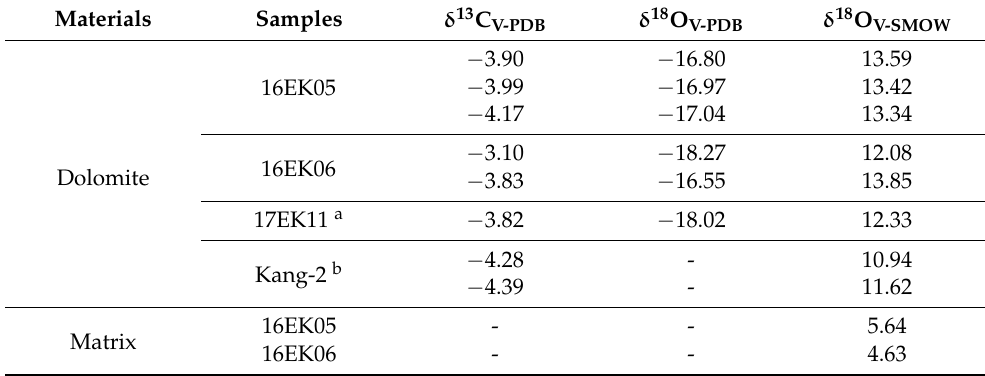
Table 2. C–O isotopes (‰) of porphyroblastic dolomite and silicate matrix in the chlorite schist.